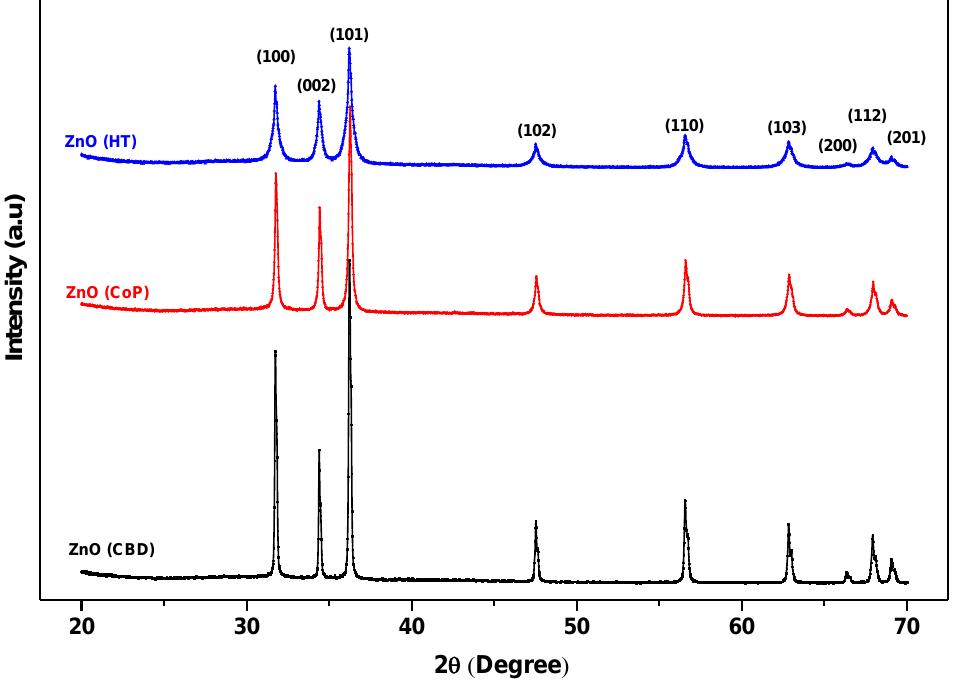
Figure 1. XRD pattern of ZnO nanostructures obtained via the HT, CoP and CBD methods.